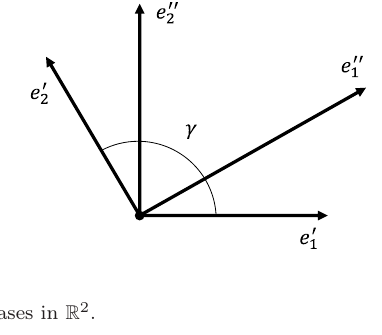
Figure 1. Reciprocal bases in R 2